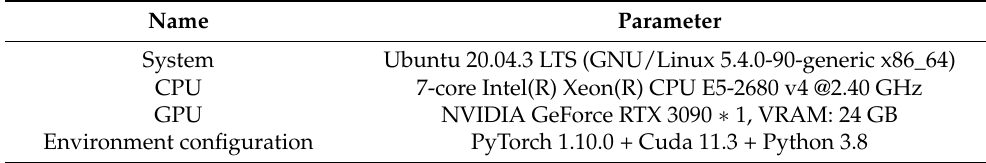
Table 5. Software environment and hardware configuration.